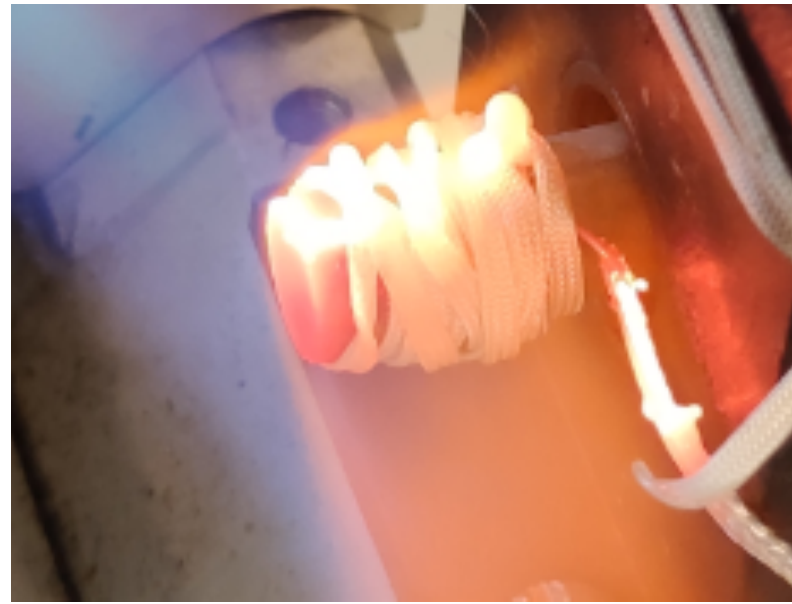
Figure 9. Probe and a thermocouple heated to 1100 °C.